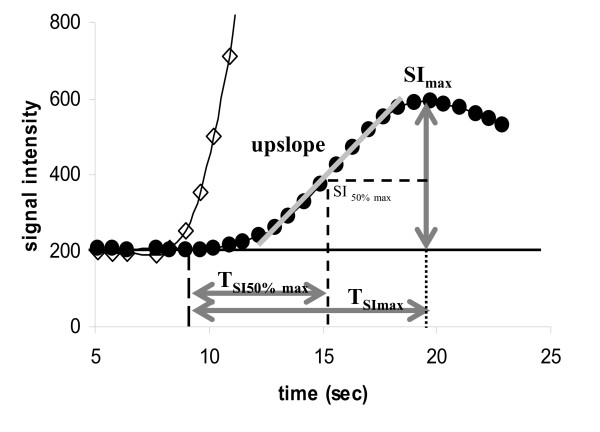
Analysis of the signal intensity (SI) curves. The left ventricular signal intensity curve (squares) is cut on the top. Upslope and SImax were assessed in (%) compared to the LV values of the medial short axis slice, TSI50%max and TSImax in seconds.